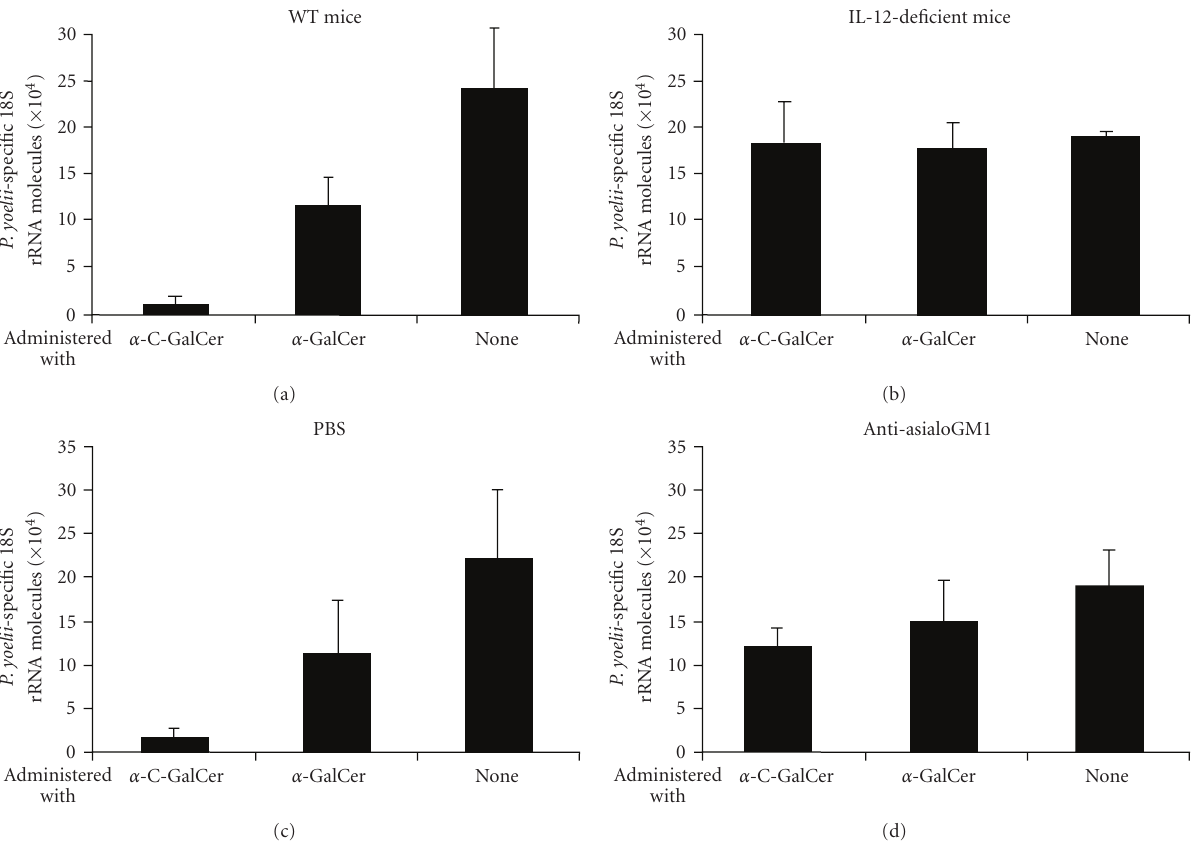
Figure 2: α -C-GalCer’s superior therapeutic activity against malaria liver stages requires IL-12 and NK cells. (a) Groups of 5 WT or IL- 12-deficient BALB/c mice were treated intraperitoneally (i.p.) with 1 μ g of either α -C-GalCer or α -GalCer or with nothing 3 days before challenge intravenously with live P. yoelii sporozoites, and then checked for malaria liver stage development. The results are expressed as the average + / − SD of 5 mice. (b) Groups of 5 WT C57BL/6 mice were treated i.p. with PBS or anti-asialoGM1 antibody 1 day prior to i.p. injection with 1 μ g of α -C-GalCer or α -GalCer, or with nothing. Three days later the mice were challenged with live P. yoelii sporozoites, and then checked for malaria liver stage development. The results are expressed as the average + / − SD of 5 mice. The data shown come from one of three experiments with similar